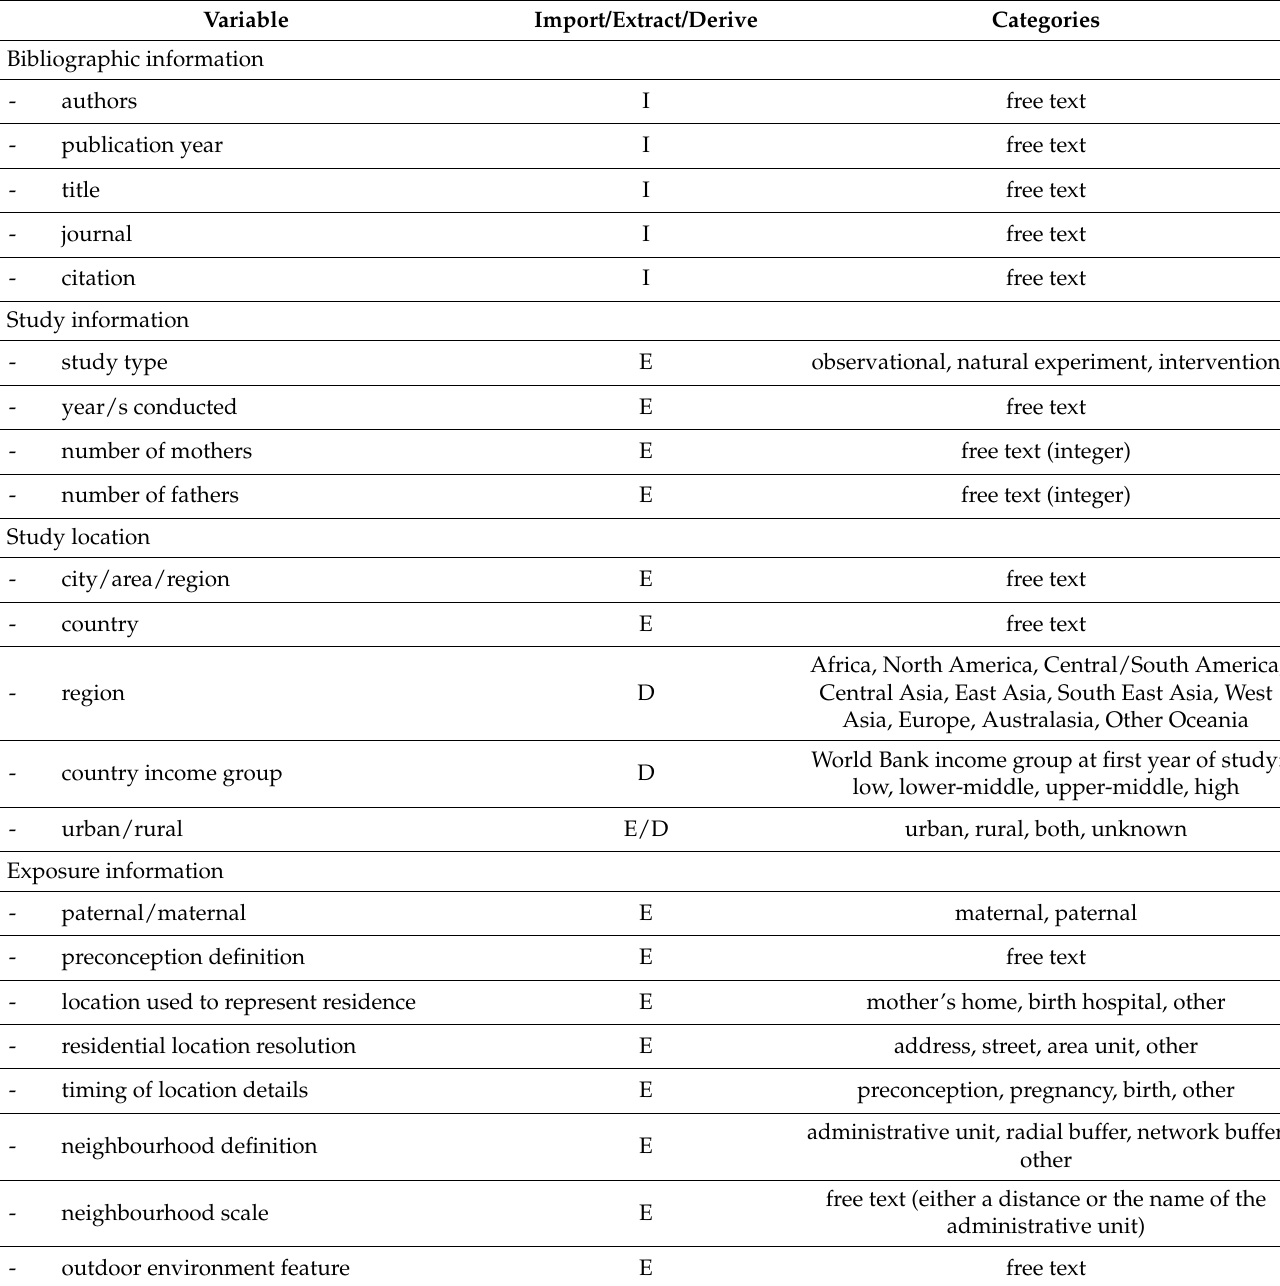
Table 2. Data extraction and coding variables. Import (I) indicates variable data will be imported from Covidence. Export (E) indicates the researcher will extract the data from the paper. Derive (D) indicates that the researcher will calculate the variable based on extracted